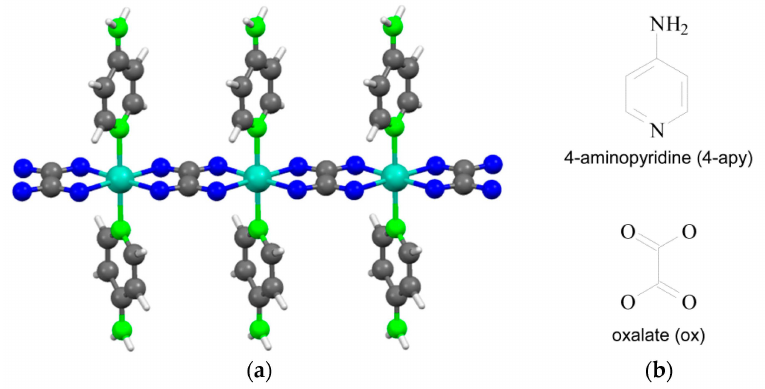
Figure 1. ( a ) Perspective view of the polymeric chain in the compound [Ni( µ -ox)(4-apy) 2 ] n (color code: C (gray); H (white); N (green) Ni (turquoise), O (blue). CSD code: UCOZOB); ( b ) Chemical diagrams of the